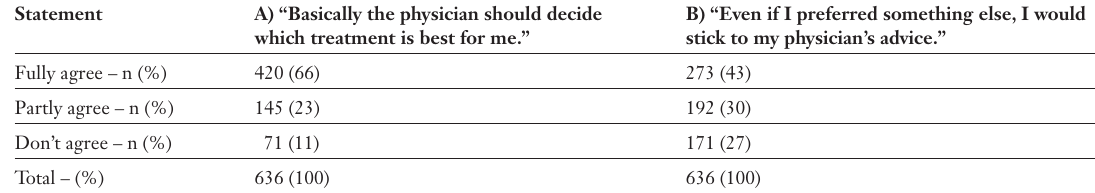
Patients’ responses to statements depict- ing typical elements of shared-decision